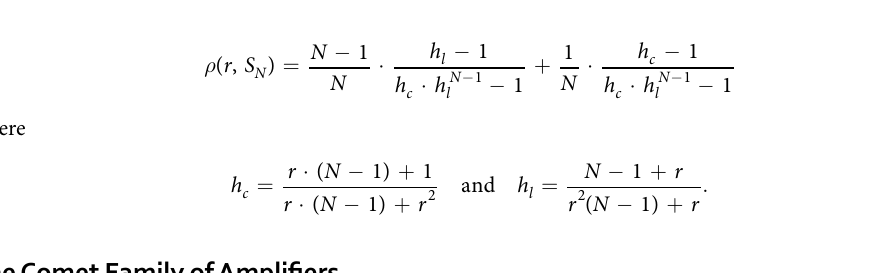
Figure 2. Fixation probabilities on the Comet graphs C Nm . The Clique graph K N and the Star S N graph appear in the leftmost and rightmost points respectively. The X-axis shows the percentage of the vertices that appear in the tail of the Comet, with the remaining vertices appearing in the head of the Comet. In each case, all data-points which appear higher that the rightmost point of the plot correspond to Comets which amplify selection more strongly than the